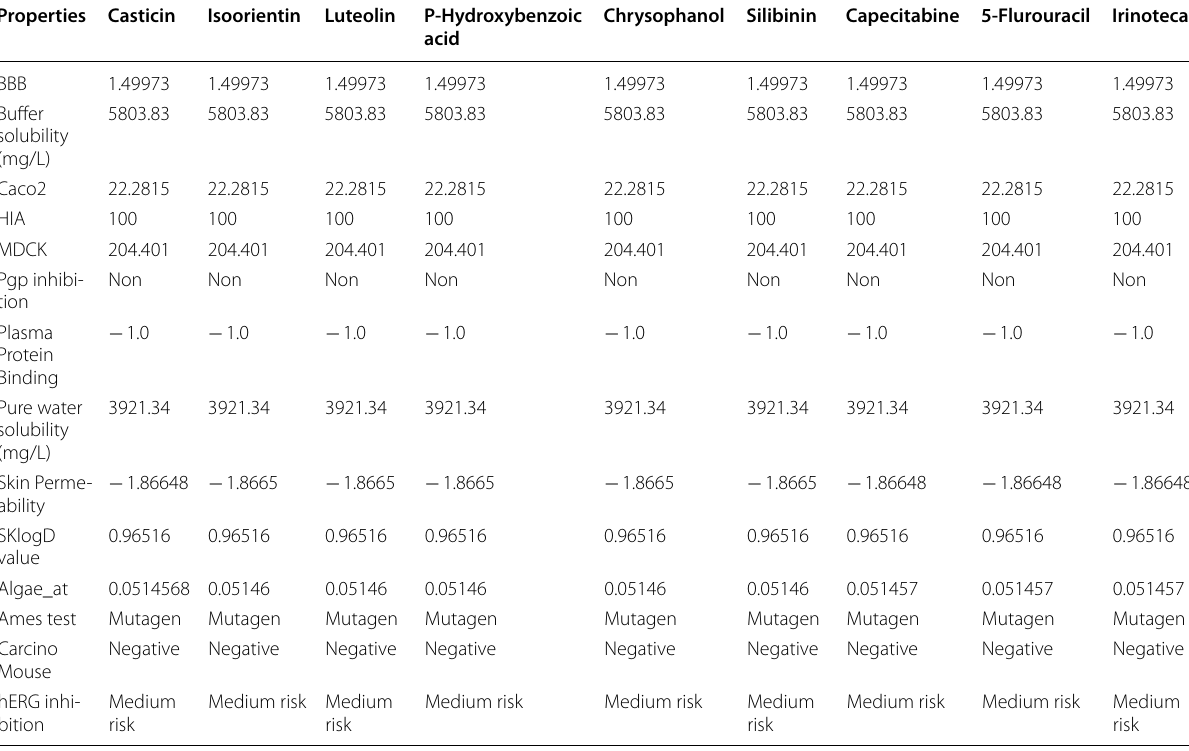
BBB, blood–brain barrier; HIA, human intestinal absorption; Pgp, phosphoglycoprotein; hERG, human ether-a-go-go related gene